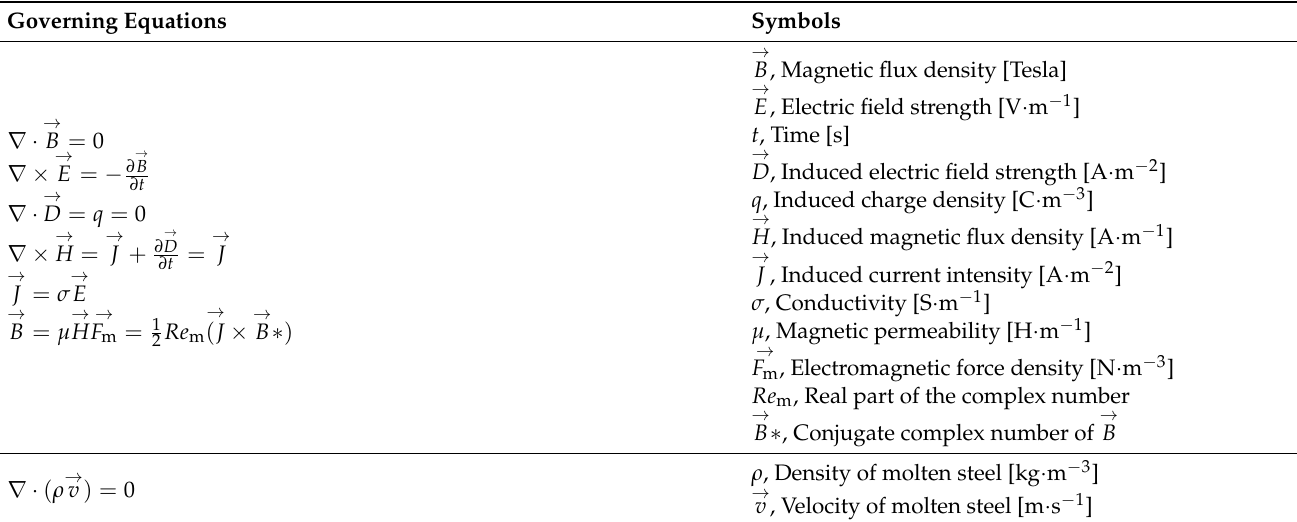
Table 1. Governing equations of the coupling solidification